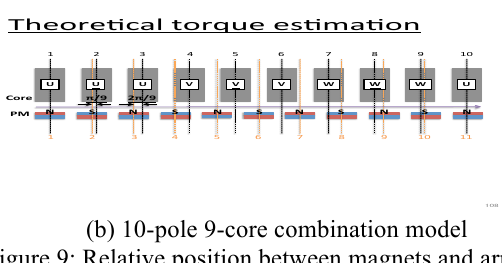
Figure 9: Relative position between magnets and armature cores in each pole-core combination (Unit: rad.).